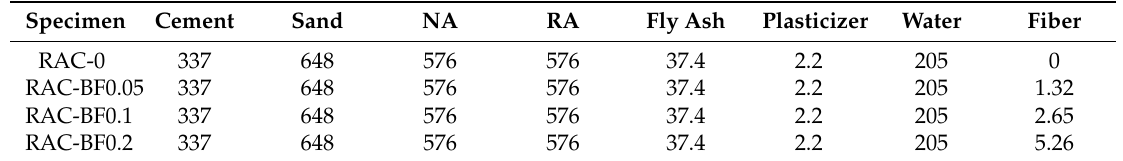
Table 4. Mix proportion of BF-reinforced RAC (kg/m 3